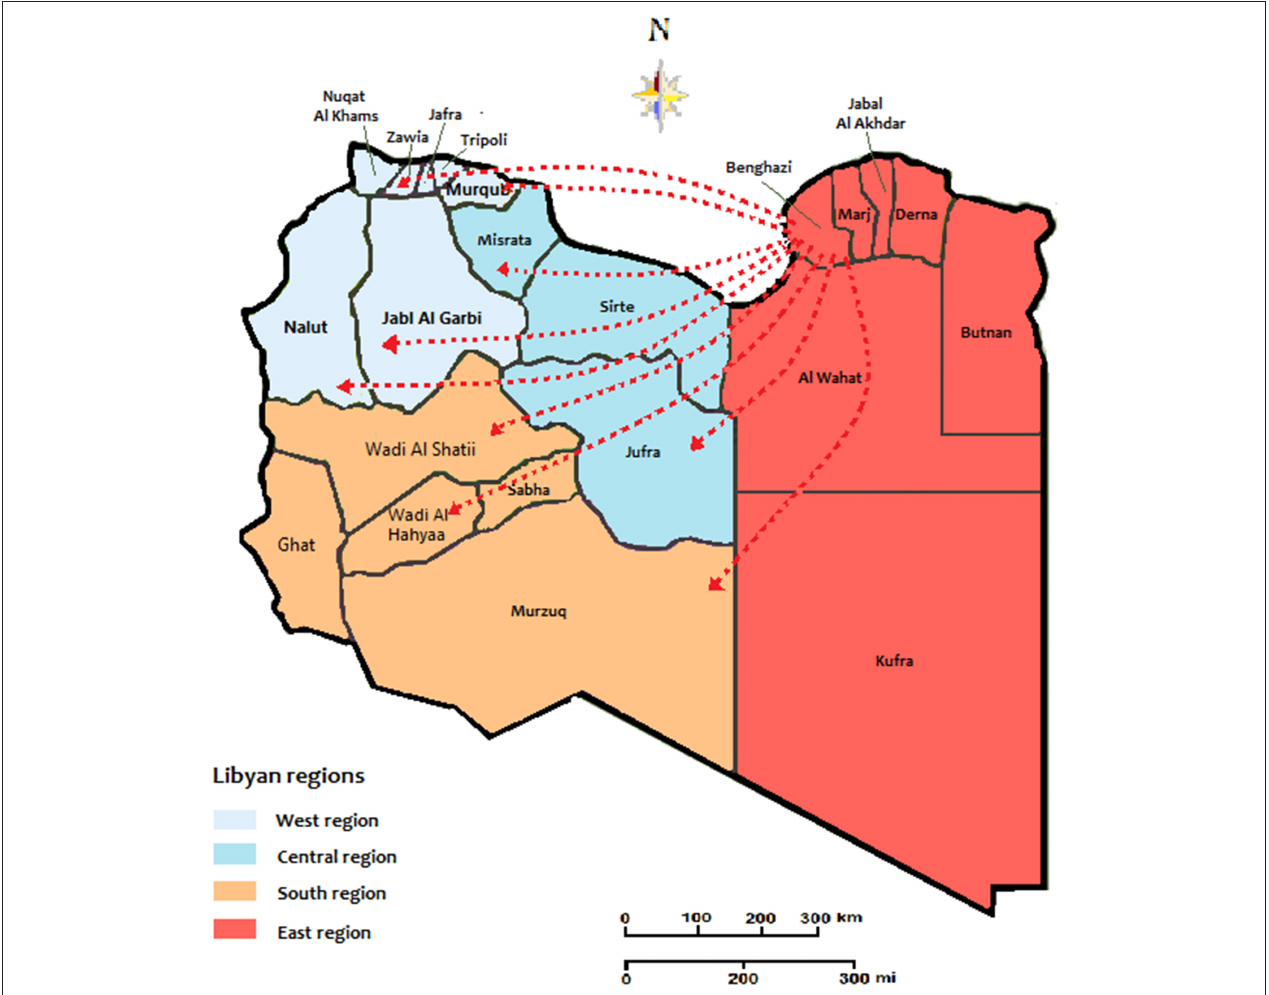
FIGURE 1 | The migration and expansion patterns of HIV cases during the conflict time of 2011-2020. The arrows indicate the directionality of virus flow movement from the residential